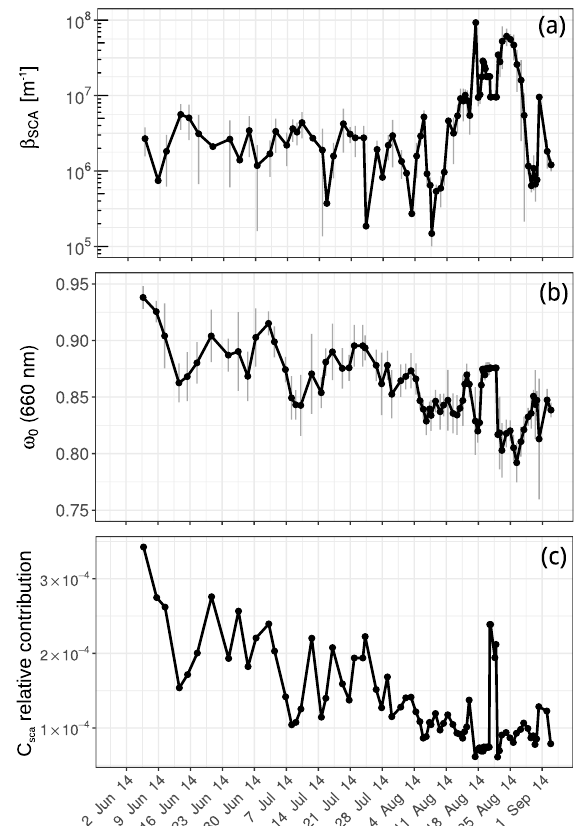
Figure 3. Filter cycle averaged data corresponding to (a) scattering proportionality constant, (b) single-scattering albedo at 660nm, and (c) relative contribution of C sca to the total multiple-scattering com- pensation ( C ref + C sca ) at 660nm. Vertical bars in (a) and (b) cor- respond to 1 standard